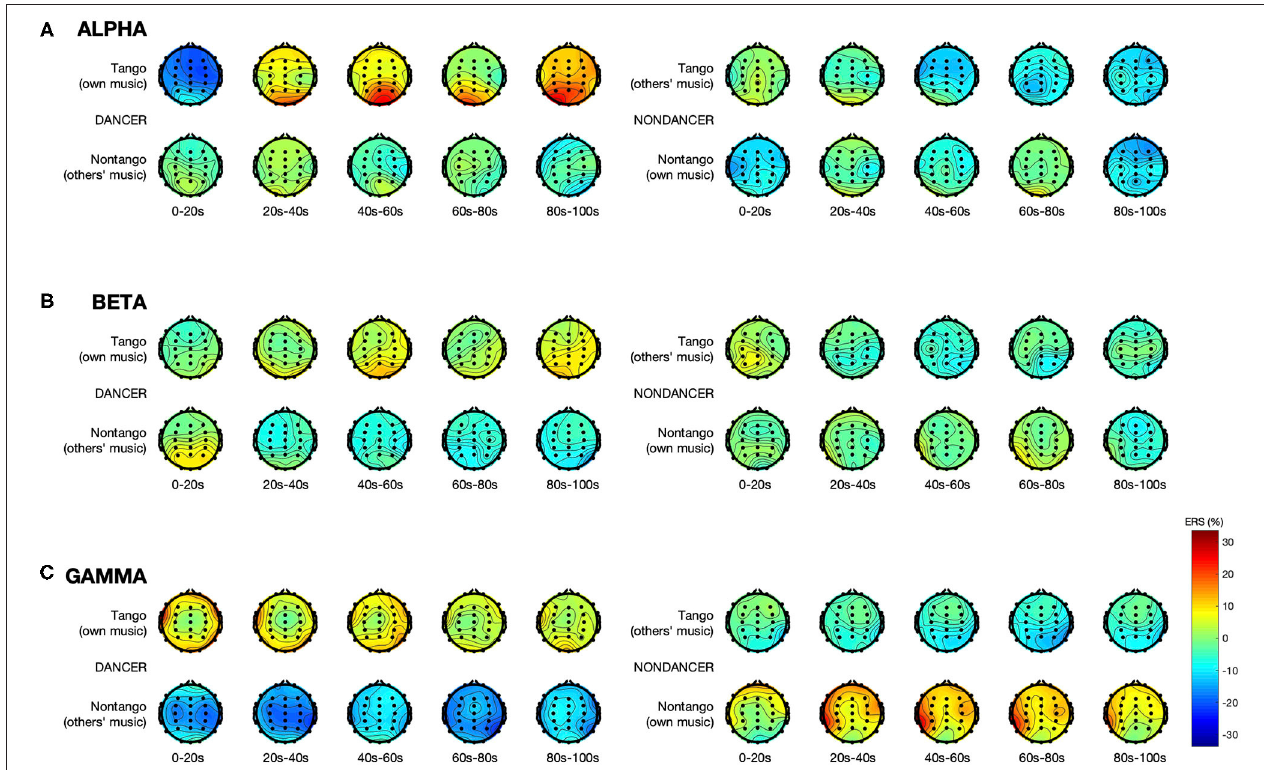
FIGURE 1 | ERS in the (A) alpha, (B) beta, and (C) gamma bands. Each topographic plot represents mean ERS calculated over a 20-s long interval, averaged over all trials within each music condition, and all participants within each group. Electrode sites, represented by the dots, are at standard positions given by the international 10–20